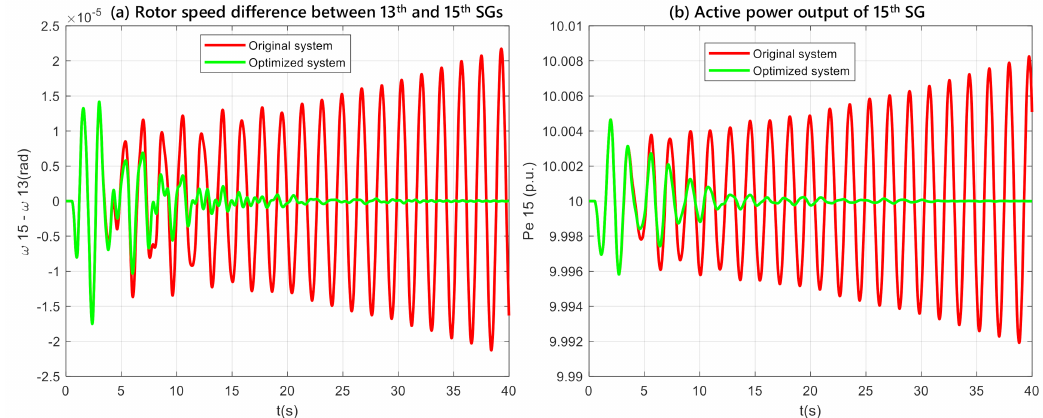
Figure 14. Comparison of simulation results in Case 4 before/after optimization. ( a ) Rotor speed difference between 13th and 15th SGs; ( b ) Active power output of 15th